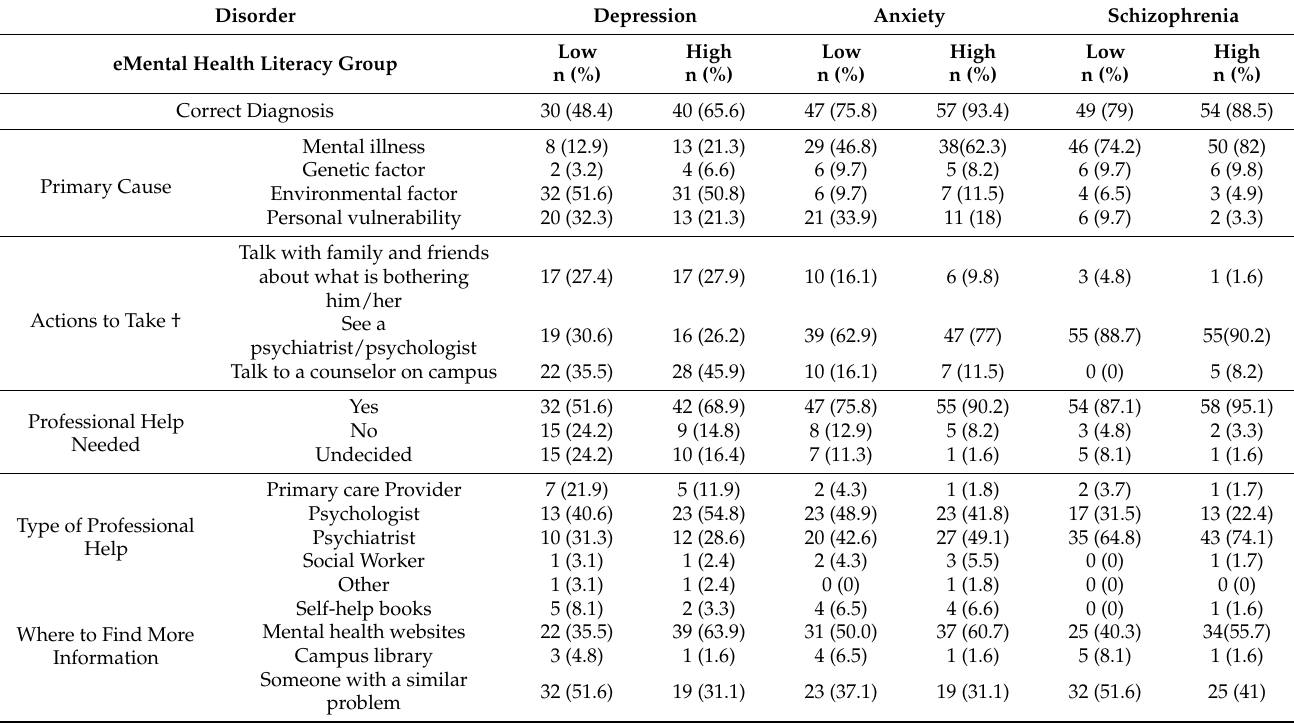
Table 4. College students’ knowledge of mental health disorders by levels of eMHL.